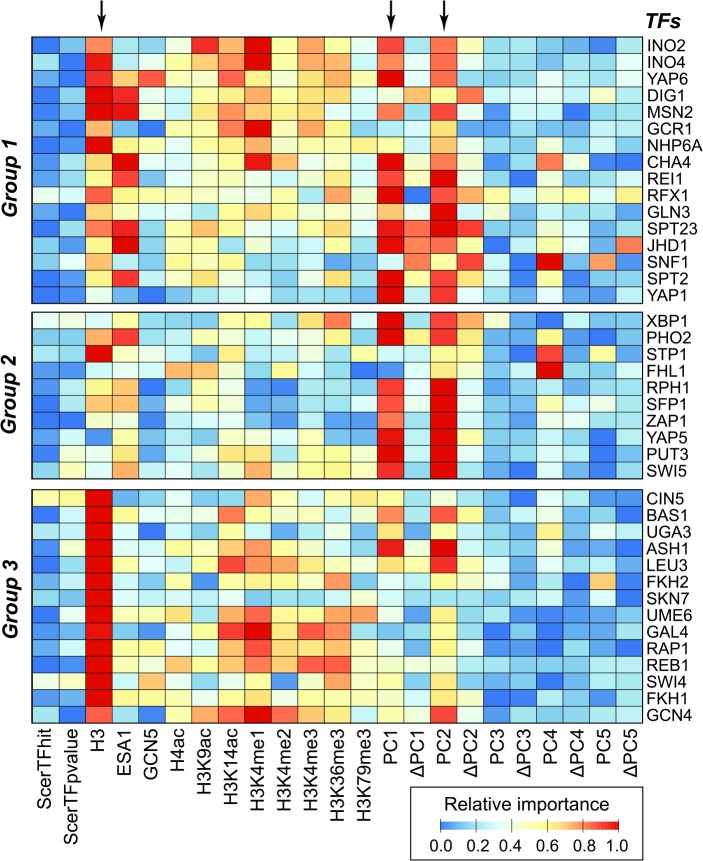
The relative importance of features for predicting binding regions of different TFs.Importance was defined as the decrease in accuracy after dropping a feature. The accuracy range was normalized to [0, 1] for each TF, where 0 is blue and 1 is red. The TFs were grouped into three classes as shown in Fig 3. Arrowheads indicate the most important features for predicting binding regions for most TFs.